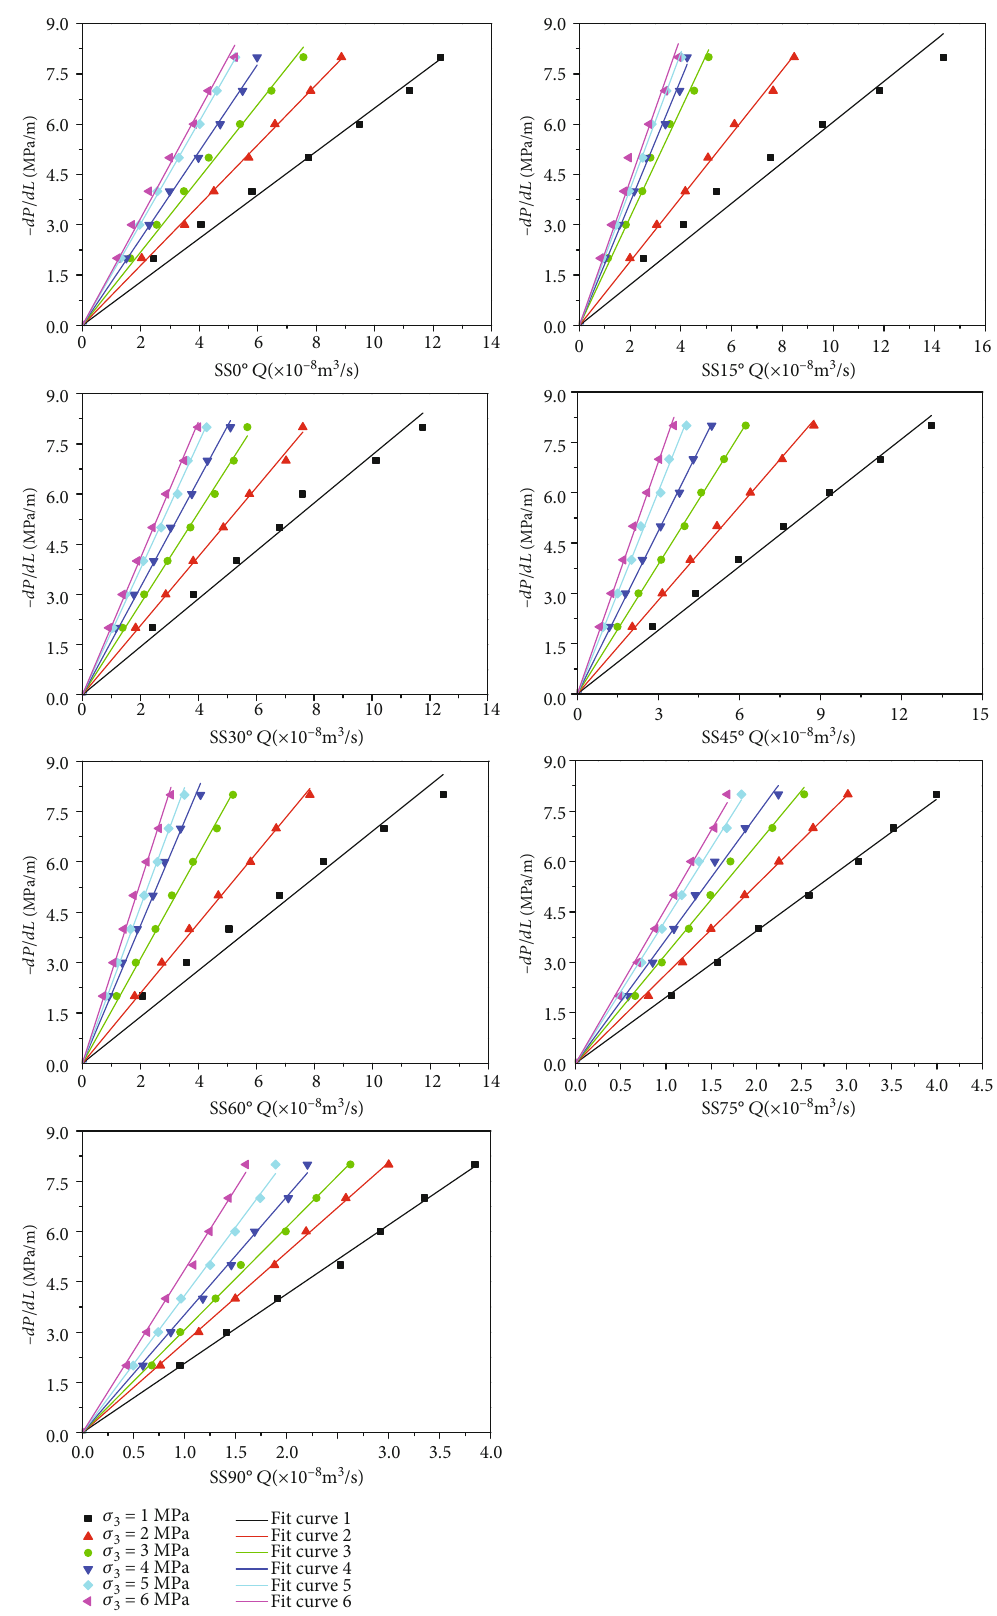
Figure 9: Relationship between volume velocity and the pressure gradient in samples with di ff erent dip angles under minimum principal